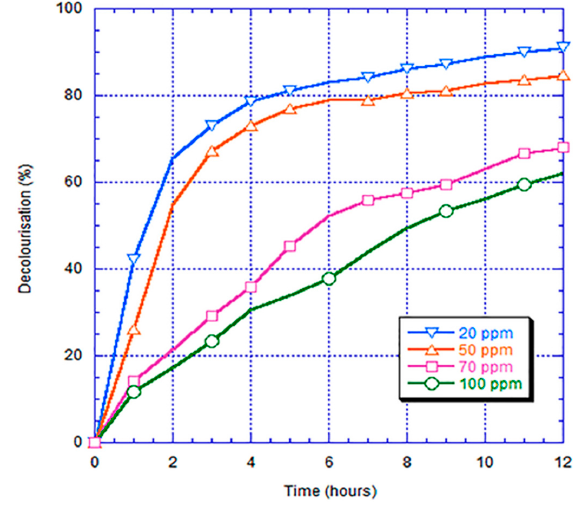
Figure 13. Chart of absorbance value vs. time for different concentrations of RB5.